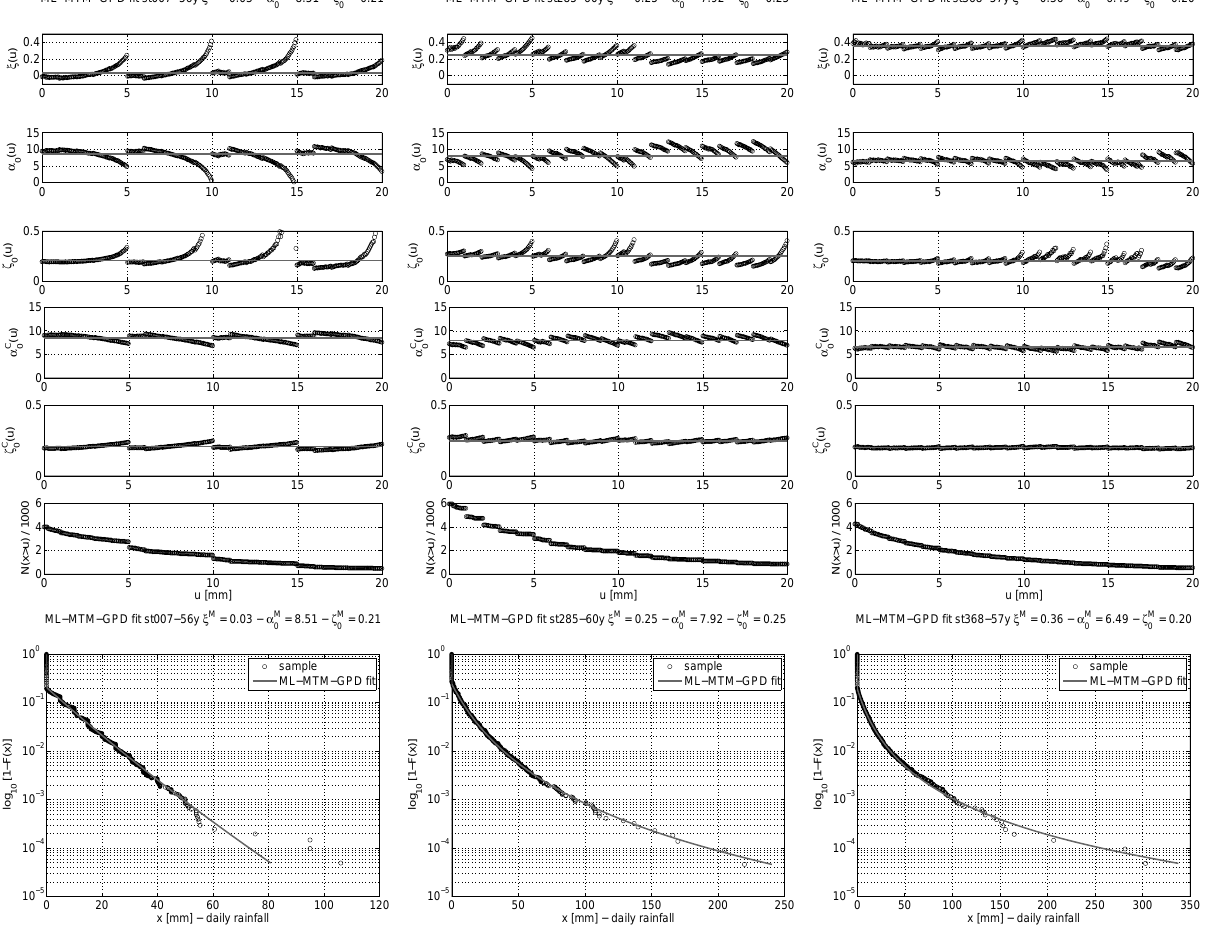
Fig. 4. Other examples of application of the MTM estimator as in Fig. 2, but here columns show the results on time series containing anomalous percentages of roughly rounded-off records. The selection of the time series was made to give examples of MTM working with different roundings (the left column shows results for a sample with many records discretized at 5mm, the other ones for samples containing many roundings at 1mm) and different values of the shape parameter (from left to right ξ ≈ 0, 0.25, 0.35). Again, comparing the fourth row of subplots against the second one, and the fifth one against the third one we can observe the benefit of hierarchical MTM application. Finally the last row compares the empirical survival function (circles) with Eq. (10) parameterized with ξ M , α M each time